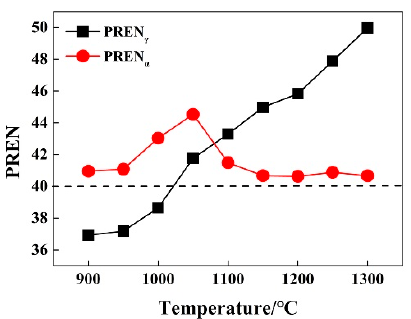
Figure 16. Pitting resistance equivalent number (PREN) of UNS S32750 solution treated at different temperatures.